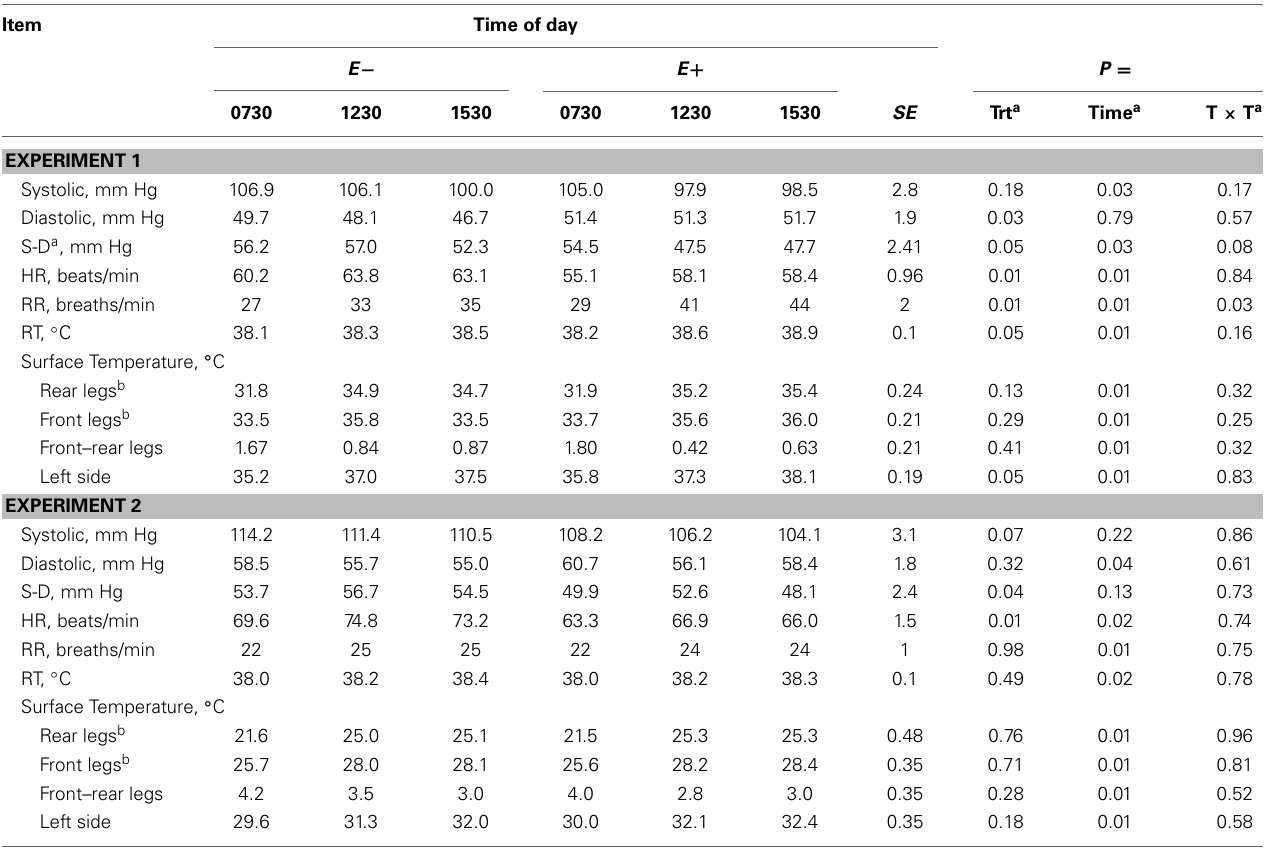
Table 6 | Blood pressure, heart rate (HR), respiration rate (RR), rectal temperature (RT), and surface temperature at different times of day for steers fed endophyte-free (E − ) or endophyte-infected (E + ) fescue seed above (Experiment 1) or within (Experiment 2) their thermoneutral